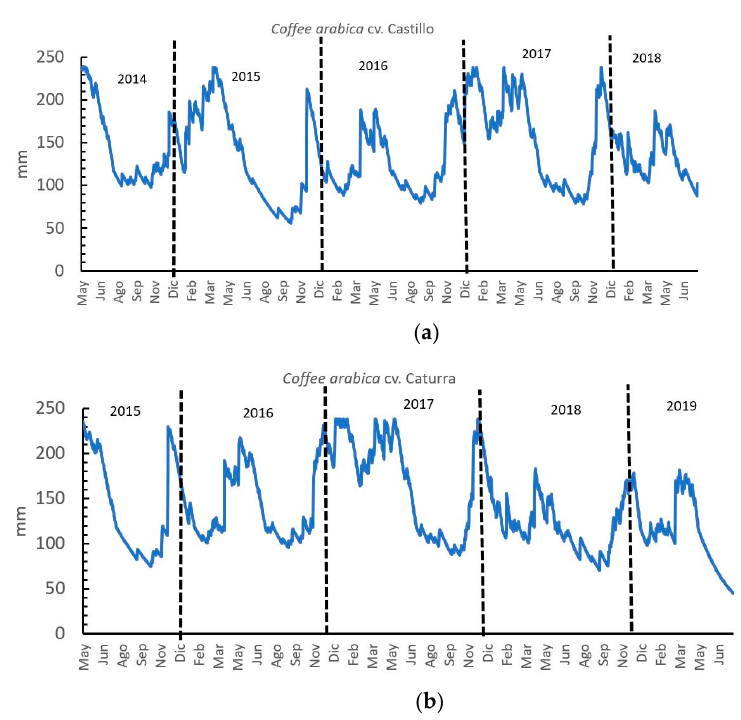
Figure 1. Soil moisture variation over five years for two coffee trials. C. arabica cv. Castillo ( a ), and C. arabica cv. Caturra ( b ). Table 4. Water balance components for two coffee varieties during four harvest